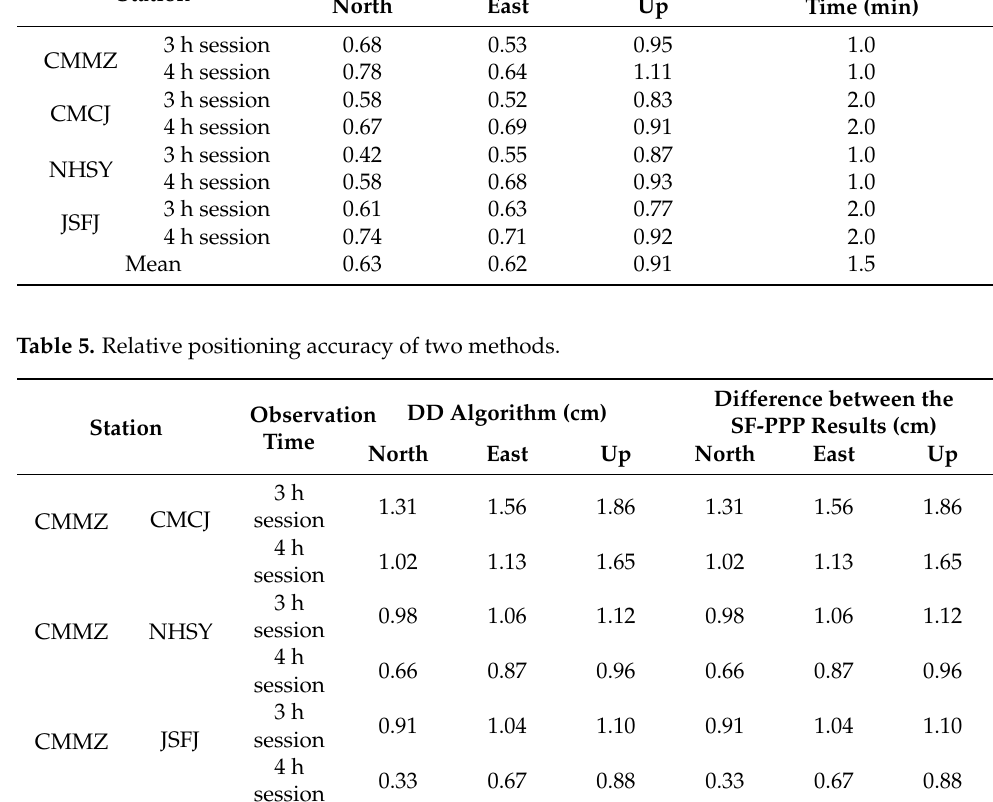
Figure 7. Positioning results of the user CMMZ for the first 3 h session.